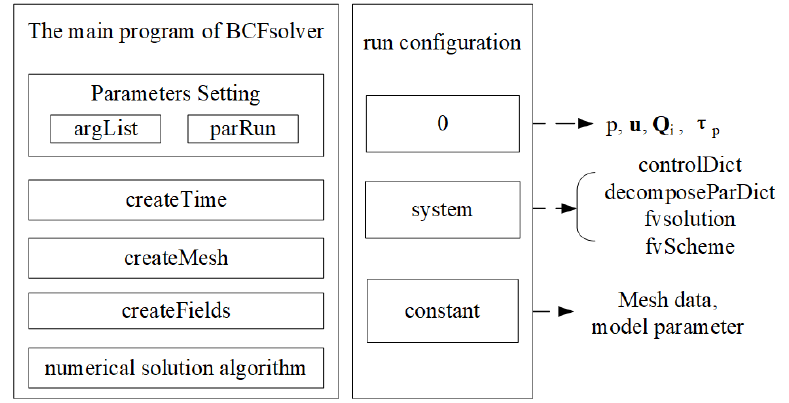
Figure 2. Numerical solver module